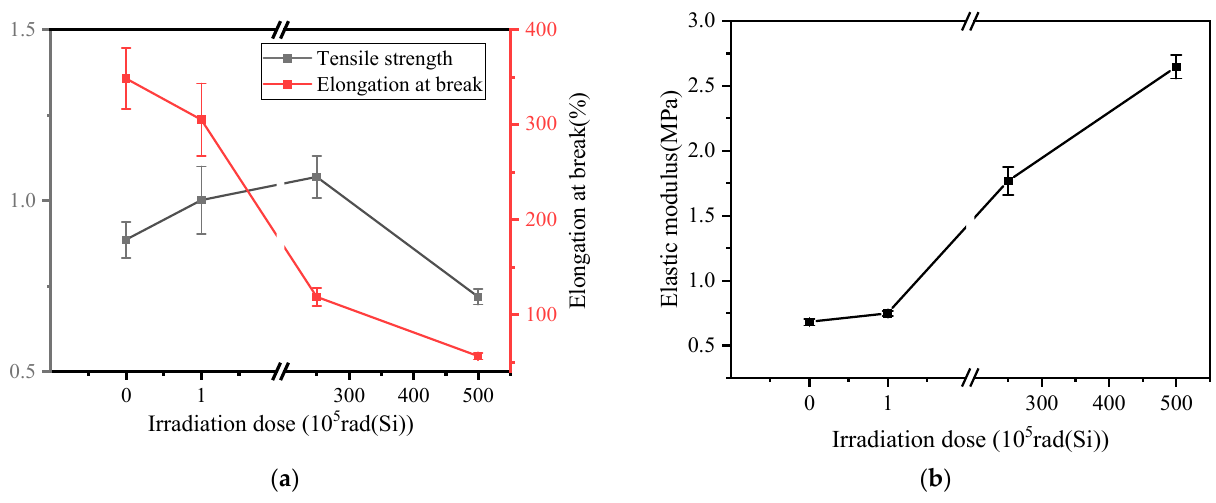
Figure 10. Changes in mechanical properties under different irradiation conditions. ( a ) Tensile strength and elongation at break. ( b ) Elastic modulus.